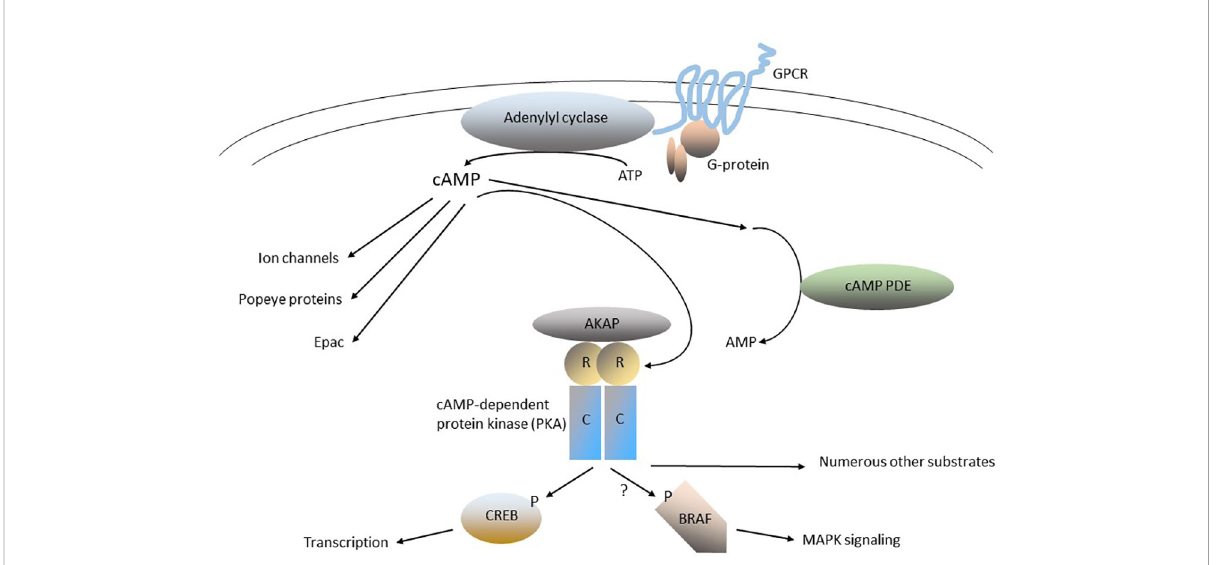
FIGURE 1 The cAMP-signaling pathway. G-protein-coupled receptors (GPCRs) are a large family of 7-helix transmembrane proteins that are the physiological receptors for circulating hormones (e.g., TSH, ACTH, FSH, and LH, among many others) and neurotransmitters that bind to their extracellular regions (the plasma membrane is indicated by the pair of curved lines). Orphan GPCRs (e.g., that encoded by GPR101 ), encode GPCRs for which the physiologic ligand has yet to be determined. GPCRs interact with trimeric G-proteins by recruiting them to speci fi c regions on their intracellular loops. G-proteins have three subunits ( a , b , or g ) and the members of the a family can be divided into stimulatory (G a s) or inhibitory (G a i) isoforms (e.g., GNAS is one of several genes encoding G a s isoforms). G a and/or G bg bind to, and regulate, one of several downstream effectors, including membrane-associated adenylyl cyclase, which catalyzes the synthesis of cAMP from ATP. cAMP is a soluble “ second messenger ” that can diffuse widely in cells. cAMP phosphodiesterases (PDEs) catalyze the hydrolysis (breakdown) of cAMP and thereby play a central in regulating cAMP signaling in cells. cAMP can activate several targets, including the cAMP-dependent protein kinase (protein kinase A, PKA), EPAC, Popeye proteins and ion channels. The PKA holoenzyme is a tetramer of 2 catalytic subunits (C-subunits, C a or C b ), and 2 regulatory subunits (R-subunits, RI a , RI b RII a or RII b ). The subcellular localization of PKA is determined by its binding to A-kinase anchoring proteins (AKAPs). In the inactive PKA holoenzyme, the R-subunits bind tightly to the C-subunits and inhibit their activity. cAMP activates PKA by binding to the R-domains, producing a conformational change that activates the C-domains. PKA is a serine-threonine protein kinase that can phosphorylate numerous substrates, depending on the speci fi c cell type and subcellular location. The cAMP-responsive element binding